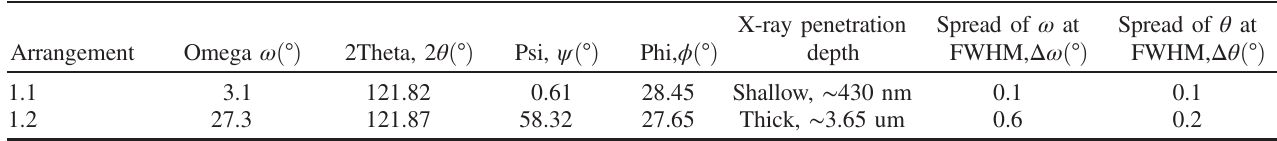
TABLE I. Two RSM experimental arrangements to measure f 123 g reciprocal points at different x-ray penetration depths. Sample label is CED-34. It is a Nb film on MgO (100)